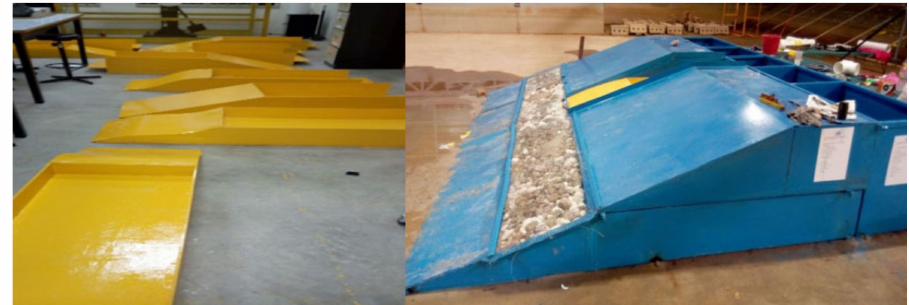
Figure 7. Ramp shapes slot and full assembly model in the